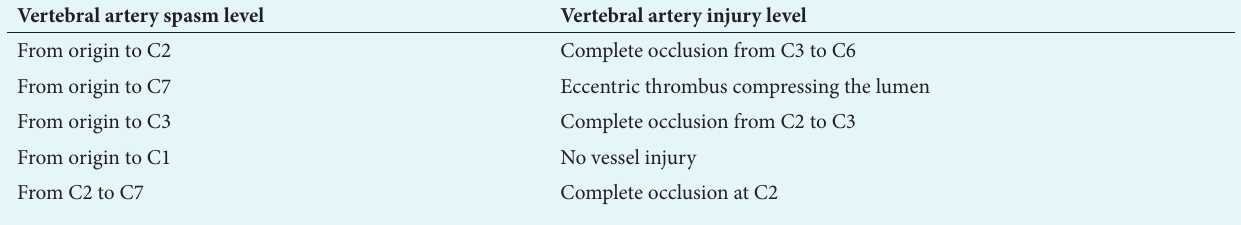
Table 2. Description of the level of vertebral artery injury in relation to the level of vertebral artery spasm Vertebral artery spasm